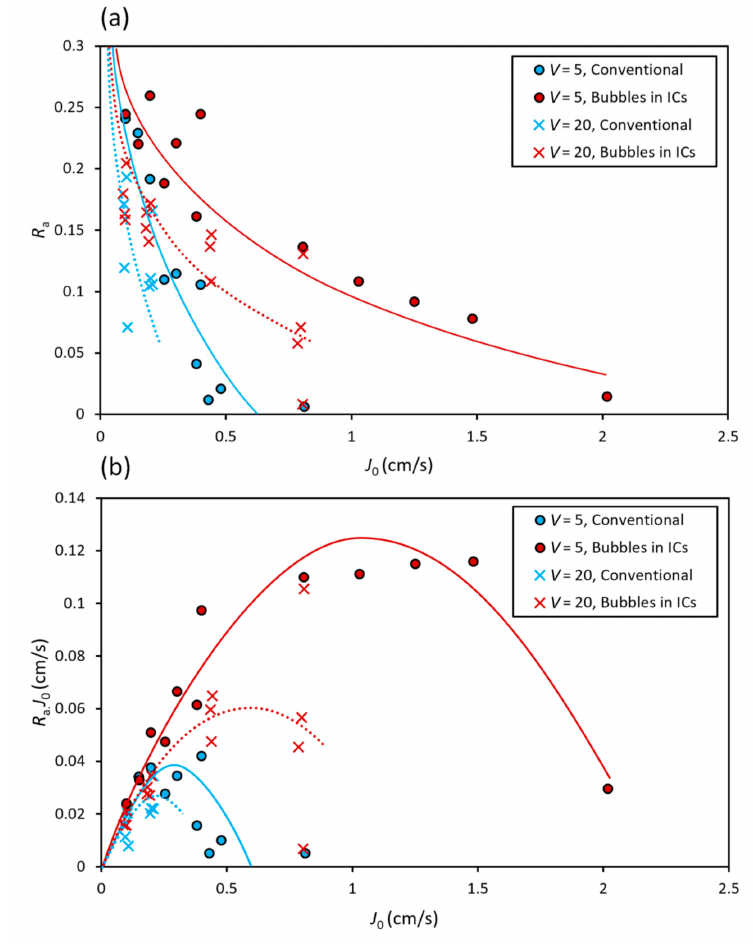
Figure 4. Measured ( a ) adsorptive recovery and ( b ) adsorptive surfactant extraction rate as a function of feed flux, for both conventional and RFC operation, at volume reduction values of V = 5 and V = 20. The fitted logarithmic curves are to guide the